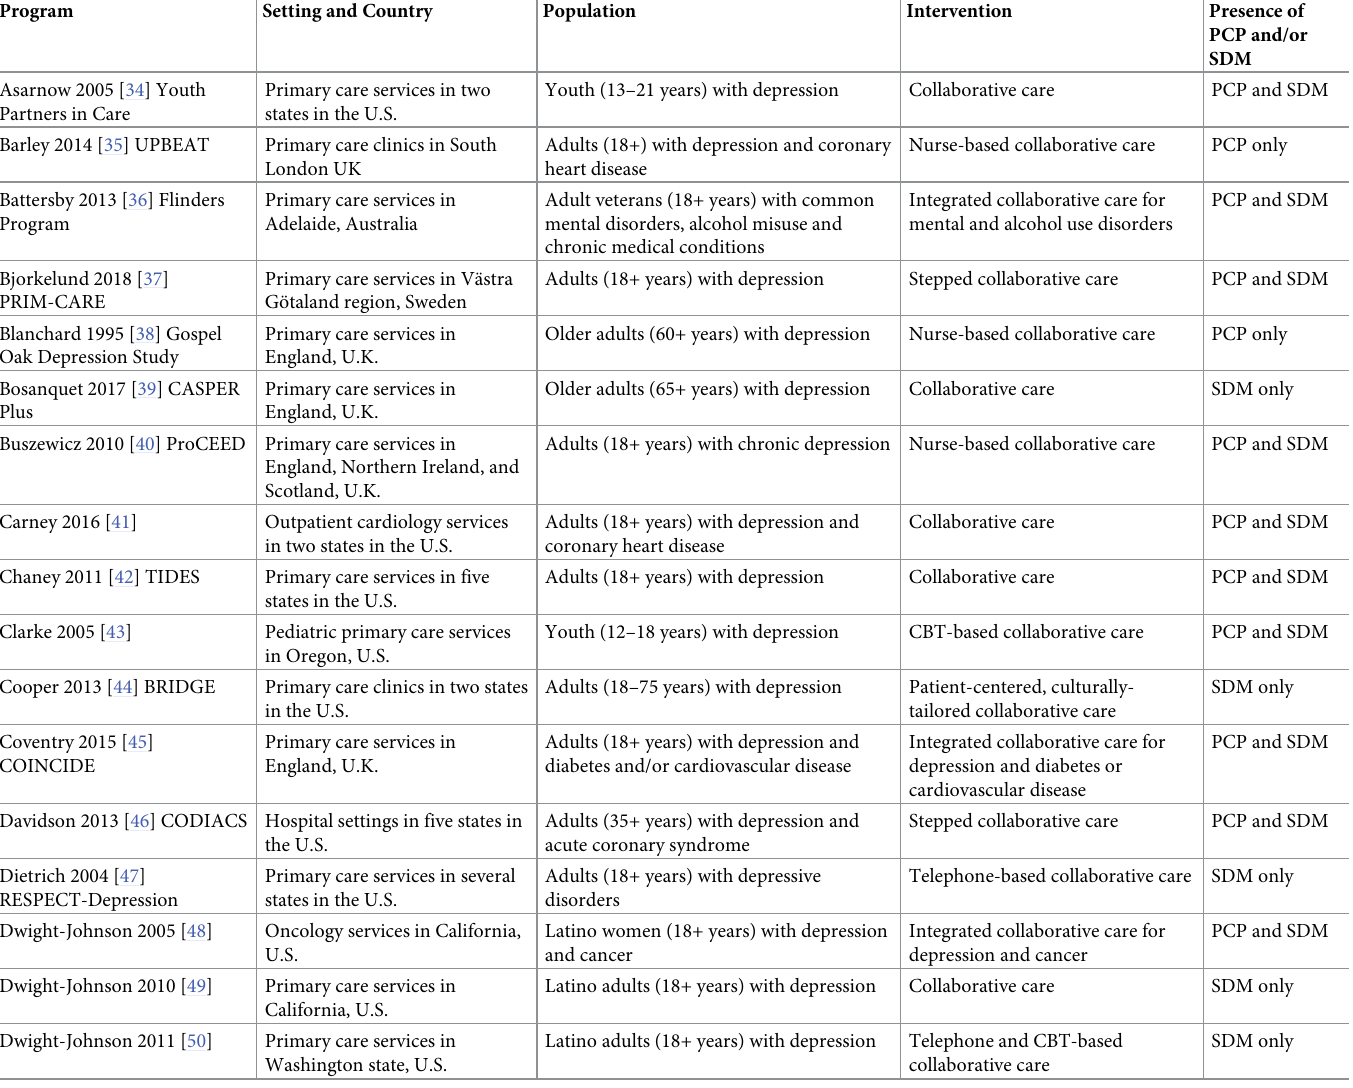
Table 1. Characteristics of programs included in the